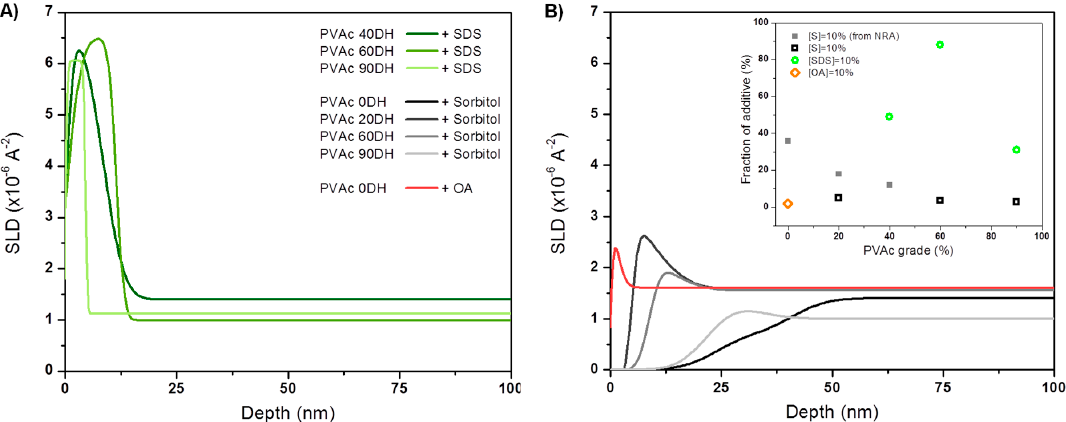
Figure 5. SLD profiles from NR data for ( A ) 15% d 8 -sorbitol, d 25 -SDS and ( B ) d 15 -OA loaded in PVAc matrices of different grade.